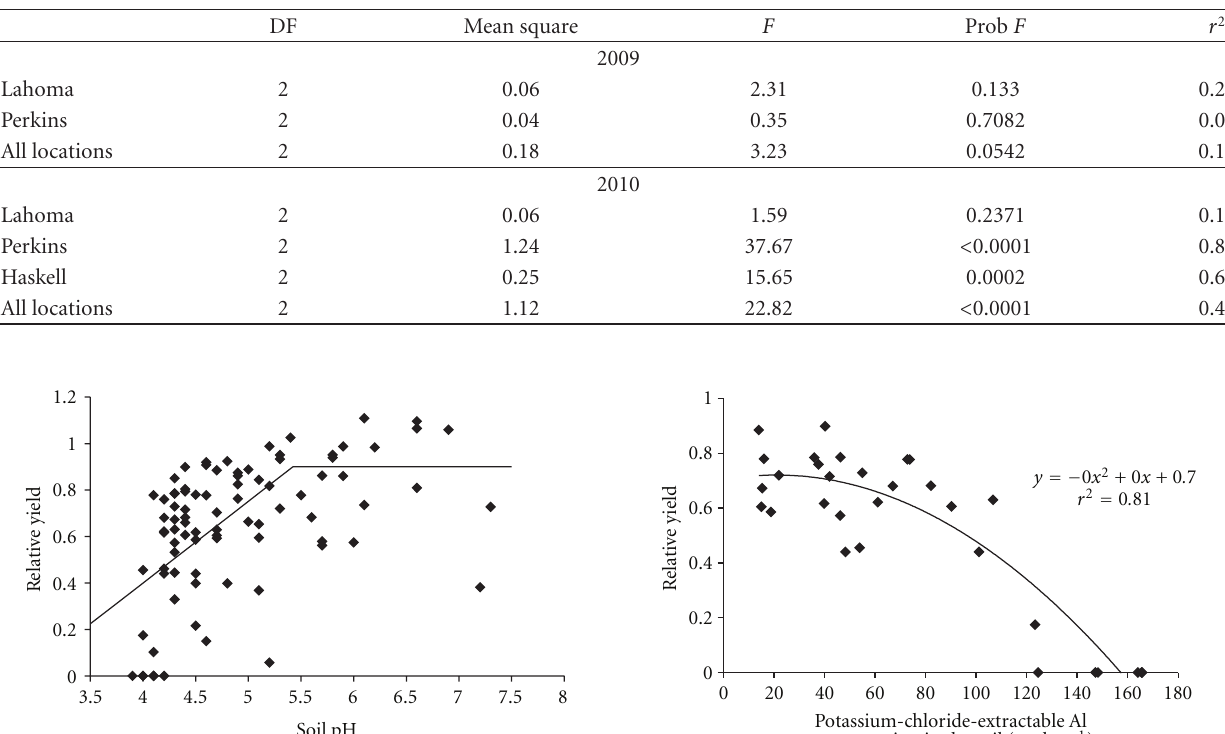
Table 4: Results from quadratic least squares regression when evaluating the e ff ect of soil pH on grain sorghum relative yield (2009 and 2010).